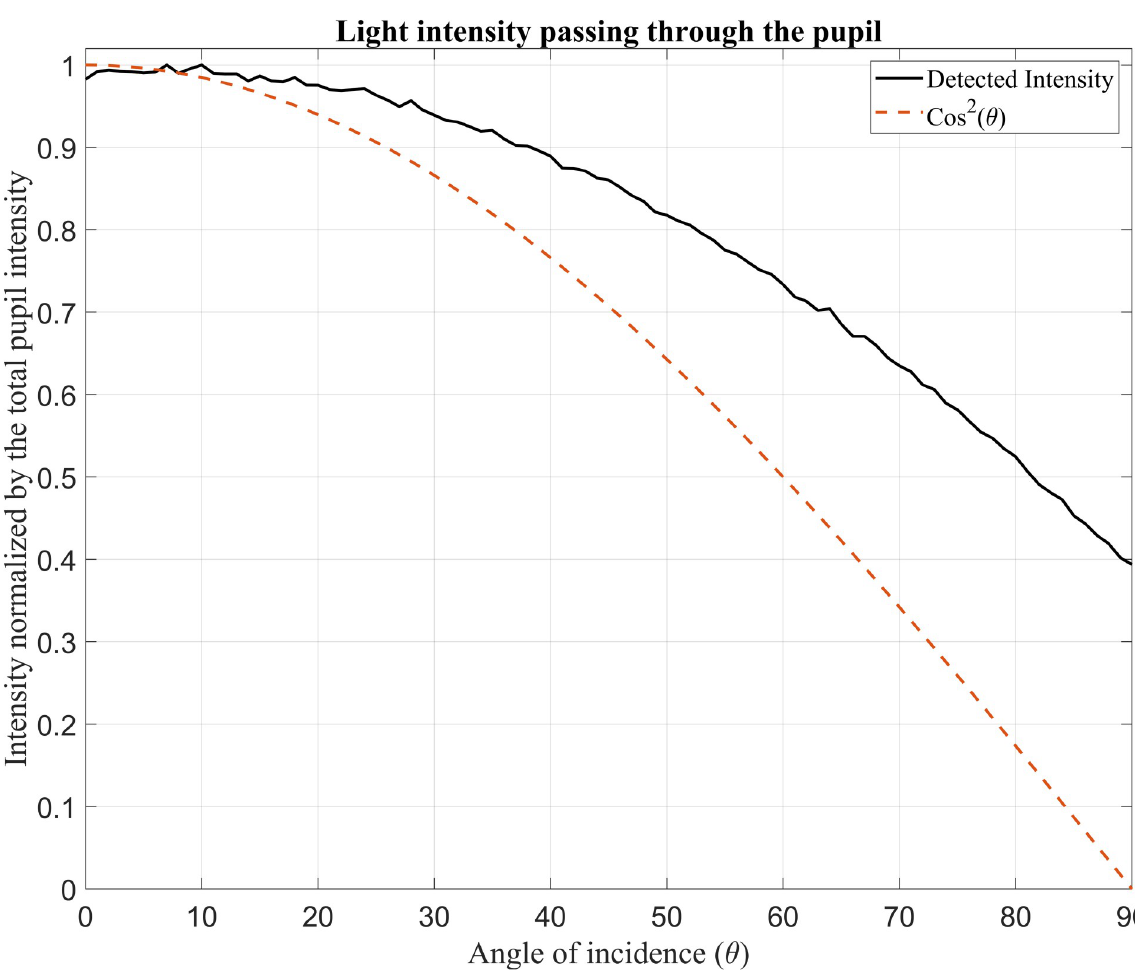
Fig 2. Normalised input intensity detected by the detector located on the pupil (Detector-P) over the incident ray